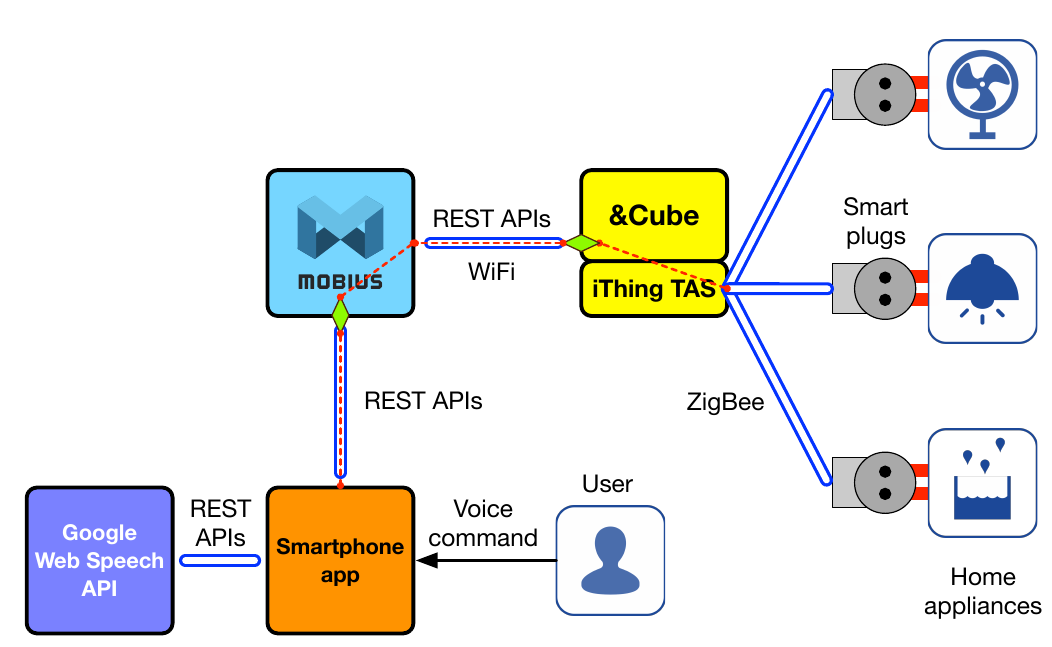
Figure 11. System architecture for iThing service